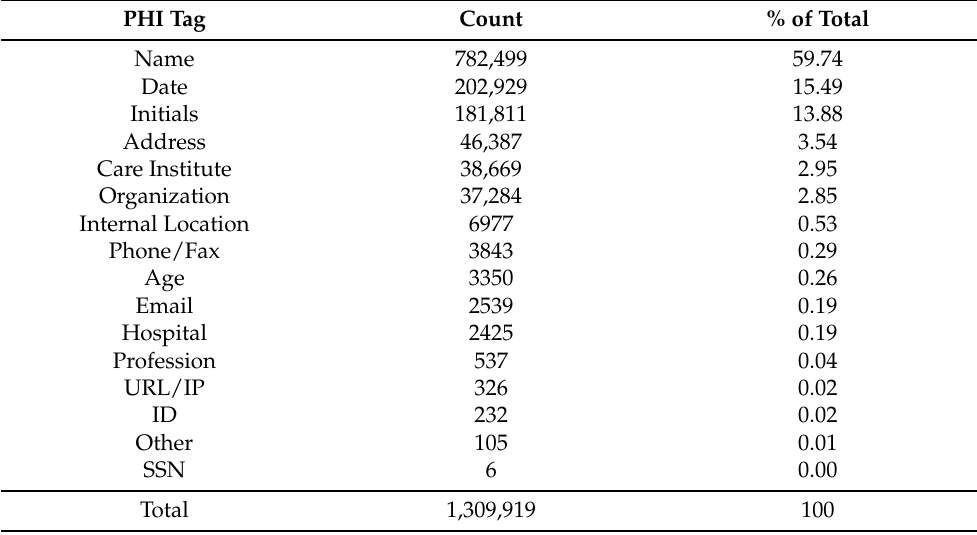
Table 1. Distribution of PHI tags in the 52 million token corpus used to develop the language models (i.e., real data). PHI was tagged by an automatic de-identification